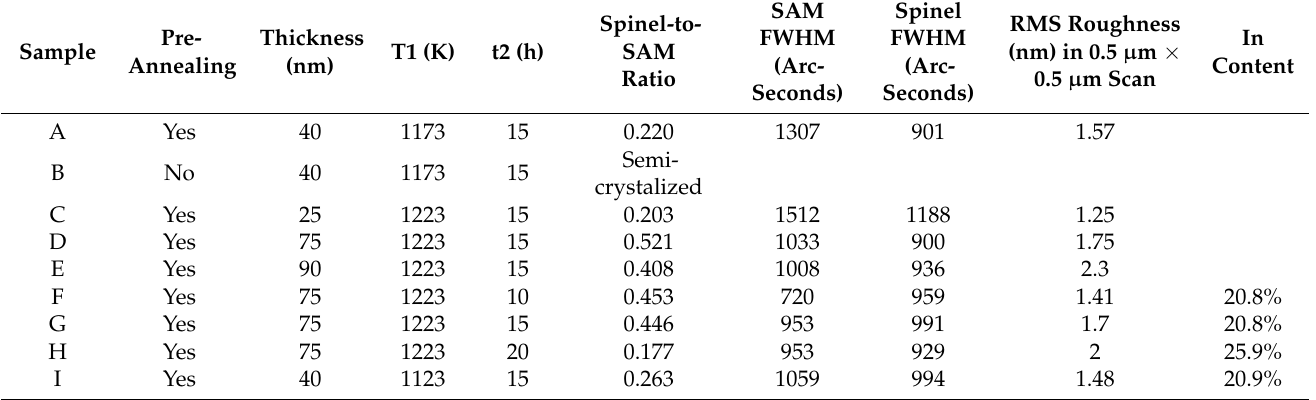
Table 1. Phase content, ω − 2 θ FWHM, and roughness for crystallized SAM layers. The